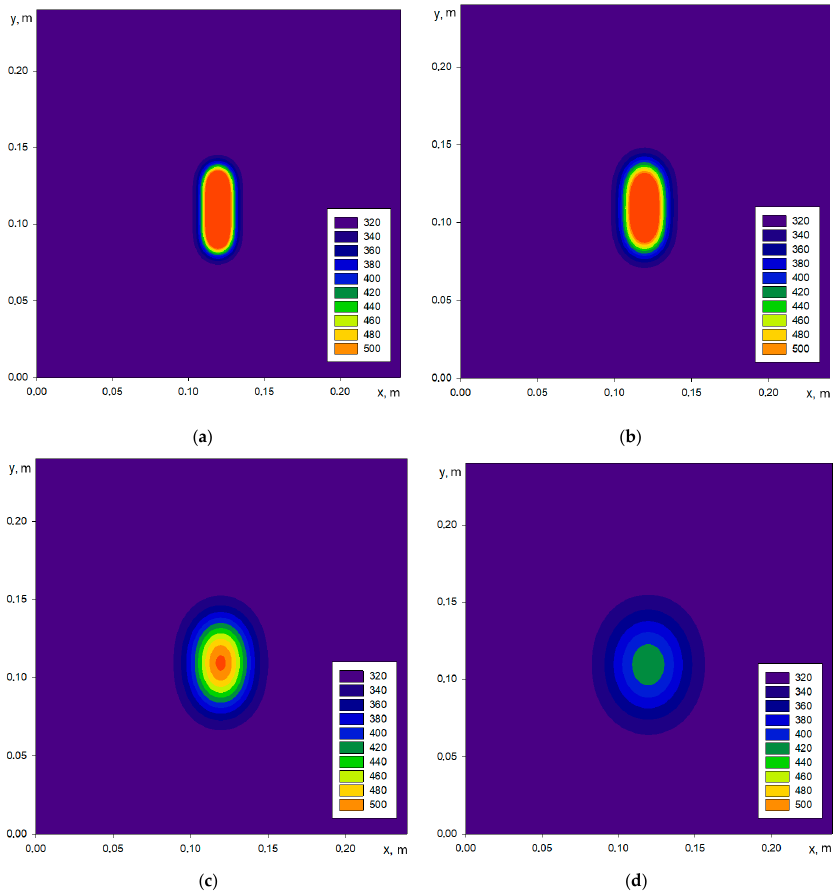
Figure 7. Isotherms on the surface of a wood layer in the vicinity of an igniting large firebrand ( 𝐿 = 50 mm; 𝐻 = 5 mm; 𝐷 = 8 mm) at different time: a — 1 s; b — 2 s; c — 5 s; d — 10 s; wind speed — 2 m/s.